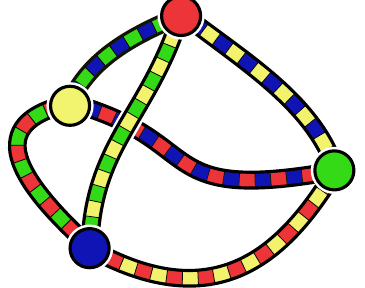
FIG. 4. The set of edges with an effectively wrong measure- ment constitutes a gauge syndrome. If noise in measurements is below a threshold, this gauge syndrome is composed of small clusters. Thus, Each cluster contributes branching points that are thus close to each other. Moreover, they have overall neutral charge, i.e., there exists a local error with such a syndrome. This is the origin of